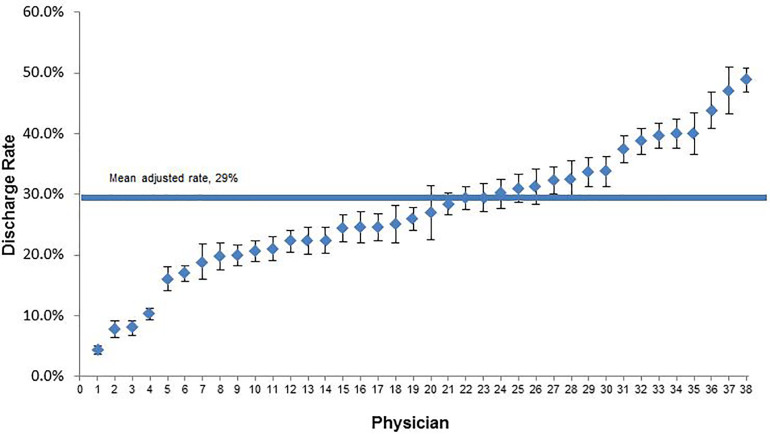
Adjusted physician-level variation in discharge rates represented by likelihood of discharge compared to average discharge rate.